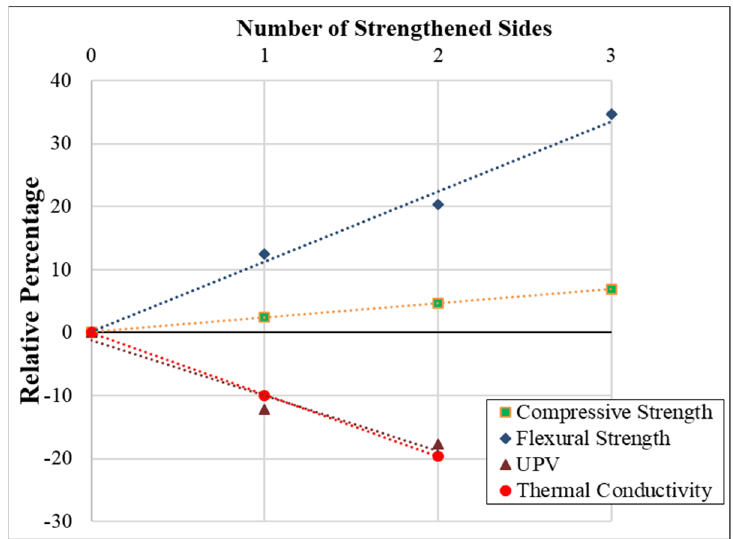
Figure 13. Relationship between various concrete characteristics and strengthening setups.